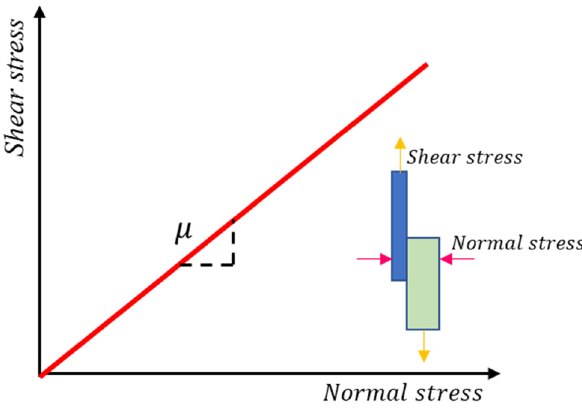
Figure 14: Coulomb ’ s law of friction.